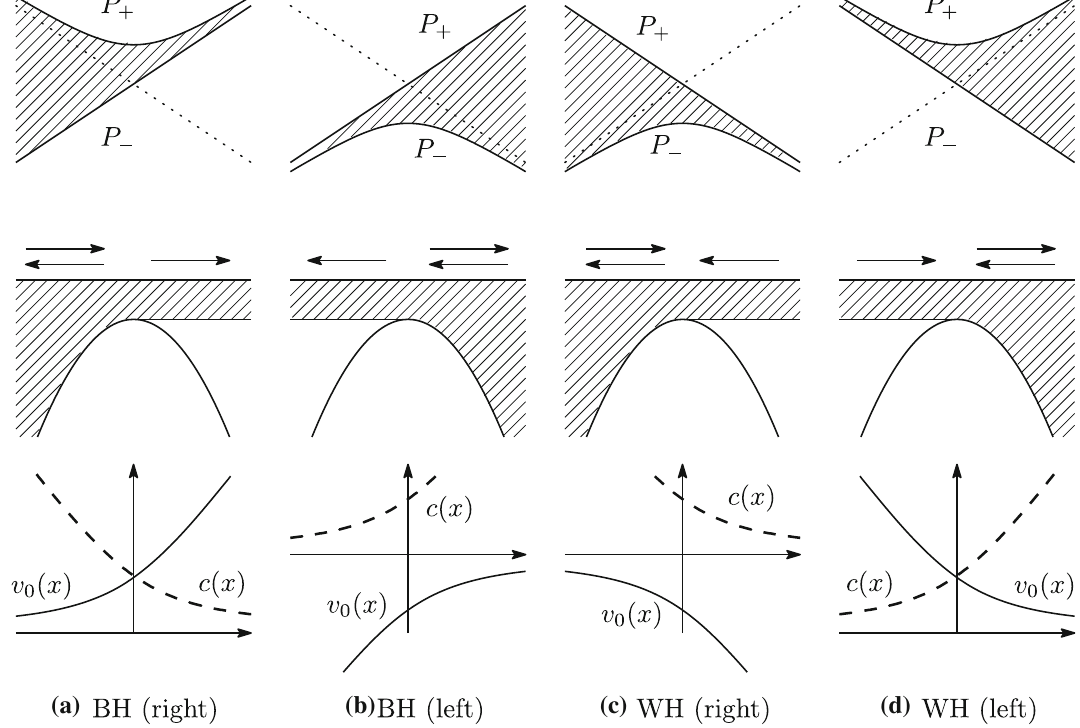
Fig. 3 Four possible acoustic event horizons ( c = | v 0 | ). (TOP) Droplets in the phase space. (MIDDLE) The particle motion in the potential. The arrows indicate the possible directions of the phonon propagation. (BOTTOM) The plots of the fluid velocity v 0 and the speed of sound c (dashed line). a Black hole (right): The phonons in the